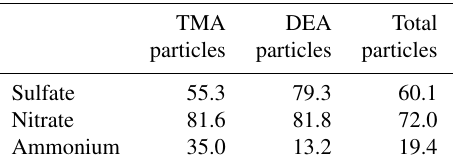
Table 3. Number fractions of sulfate, nitrate, and ammonium in TMA-containing particles, DEA-containing particles, and total par-